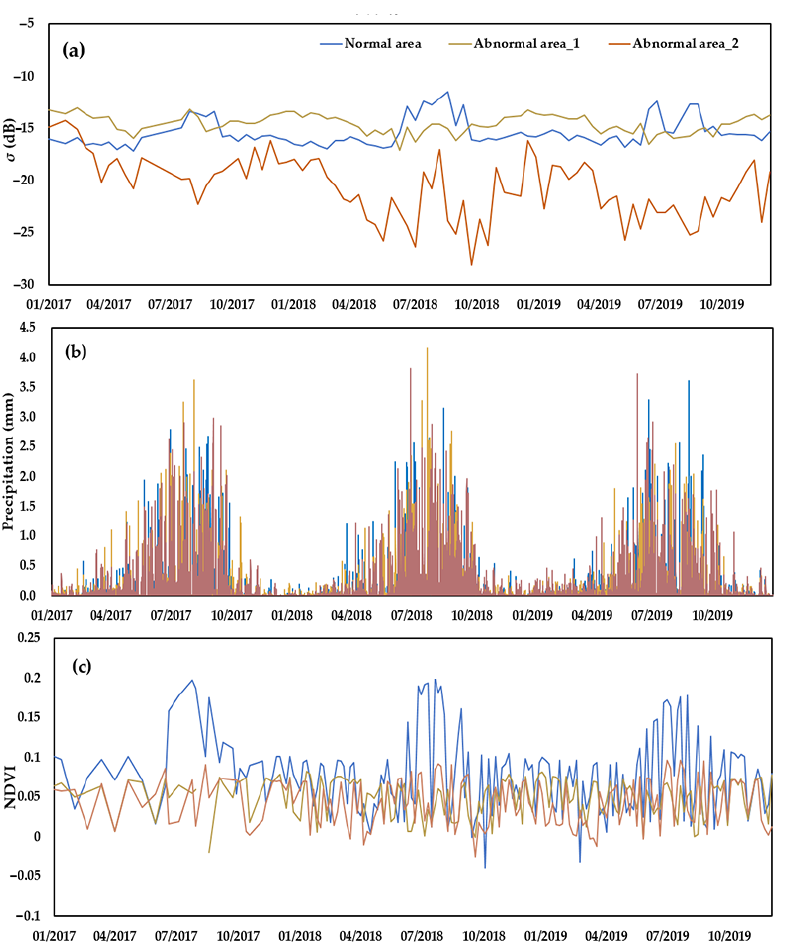
Figure 16. Comparison of normal and abnormal regions. ( a ): σ ° ; ( b ): Precipitation; ( c ): NDVI.